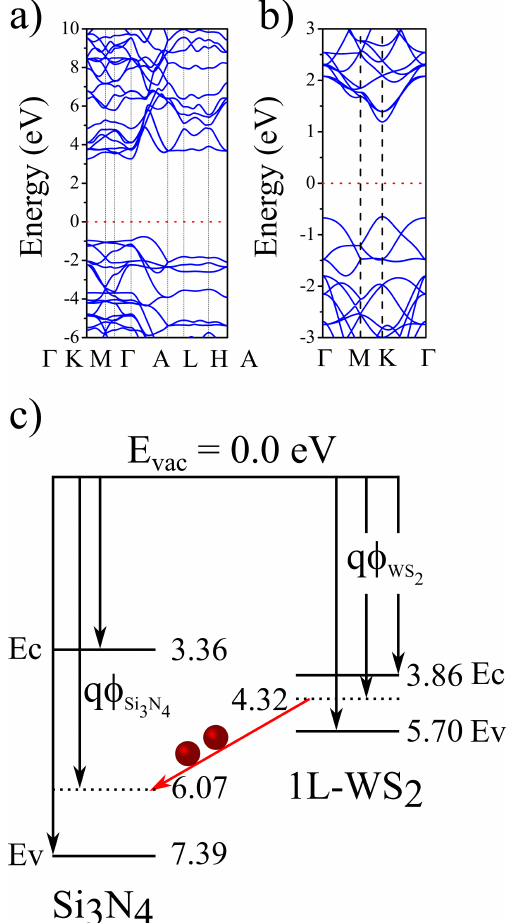
Figure 2. The electronic energy dispersions for bulk Si 3 N 4 and 1L-WS 2 are shown in ( a , b ), respectively. The Si 3 N 4 substrate is found to be a wide gap insulator with an indirect band gap while the 1L-WS 2 is known as a direct band gap semiconductor. The panel in ( c ) shows an electronic band diagram for each material, indicating a trend for a charge transfer from WS 2 to the Si 3 N 4 substrate. Each value in ( c ) has been multiplied by − 1 for sake of convenience. Here, E v and E c stand for the energies of valence and conduction bands in this same